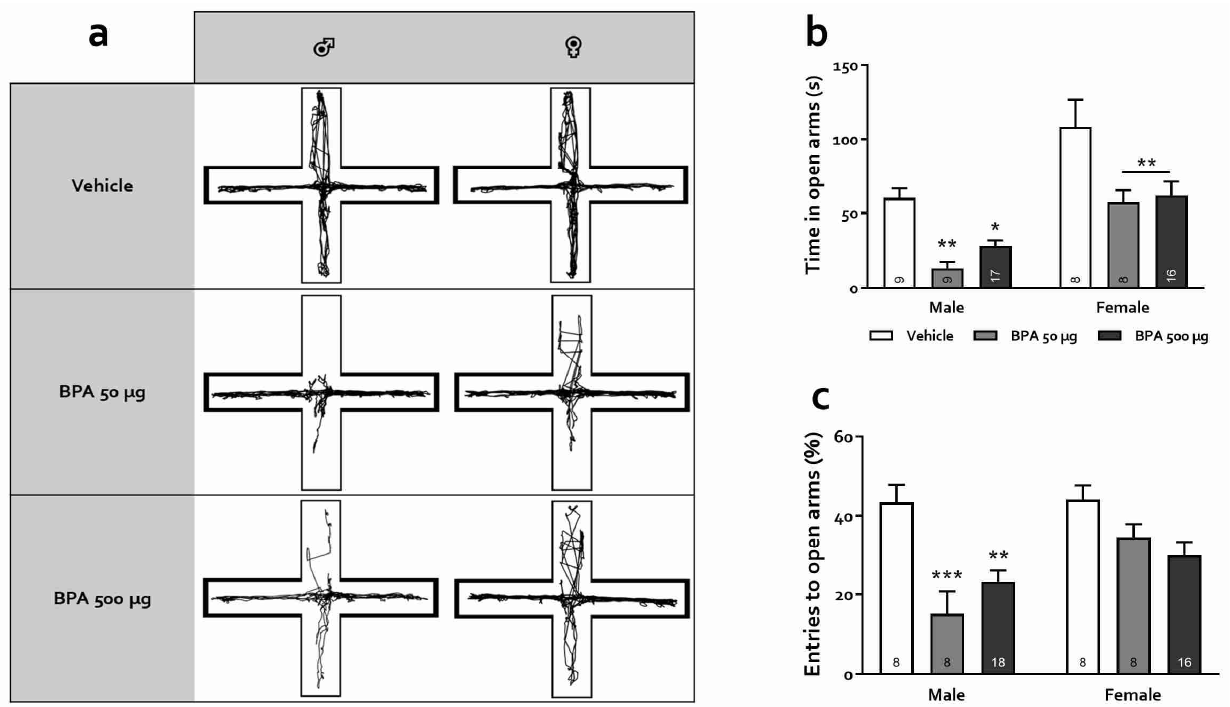
Figure 4. Effects of BPA on the EPM test. ( a ) Representative trajectory for each treatment; thicker contouring lines represent the enclosed arms; ( b ) Time spent in the open arms, and ( c ) Percentage of open arm entries over the total number of open and closed arms entries in male and female rats. Results are expressed as mean ± SEM. Numbers within bars indicate animals per group. *: p < 0.05; **: p < 0.01; ***: p < 0.001 vs. respective vehicle groups.